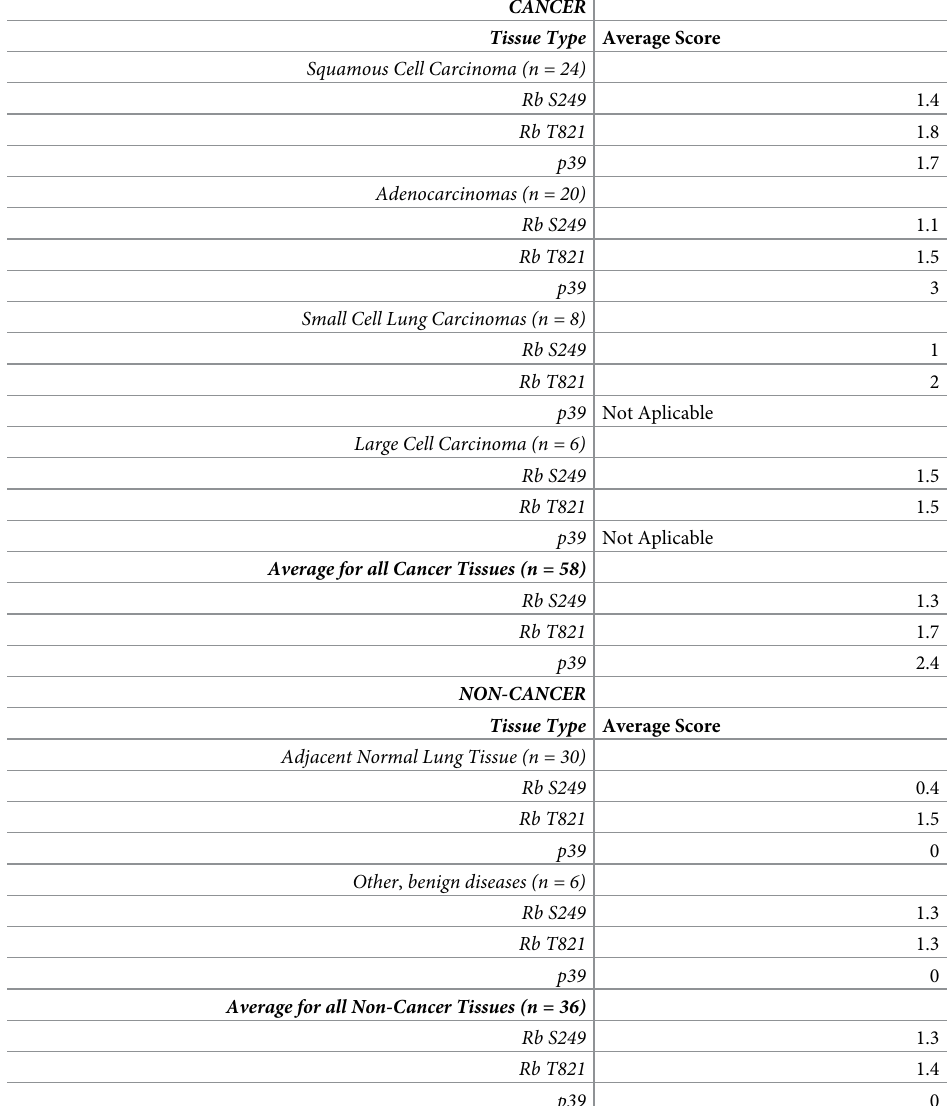
Table 4. Averaged scores from three pathologists and the Aperio system, for phospho-Rb S249, phospho-Rb T821 and p39 staining, broken down by tissue type. In average, staining scores for phospho-Rb S249 and phospho-Rb T821 did not significantly differ between cancer tissues relative to non-cancerous controls, even when breaking the scoring down into histological subtypes. The difference of the biggest magnitude was the one observed for p39 staining, which showed a score of 2.4 in cancer tissues, relative to 0 for non-cancer